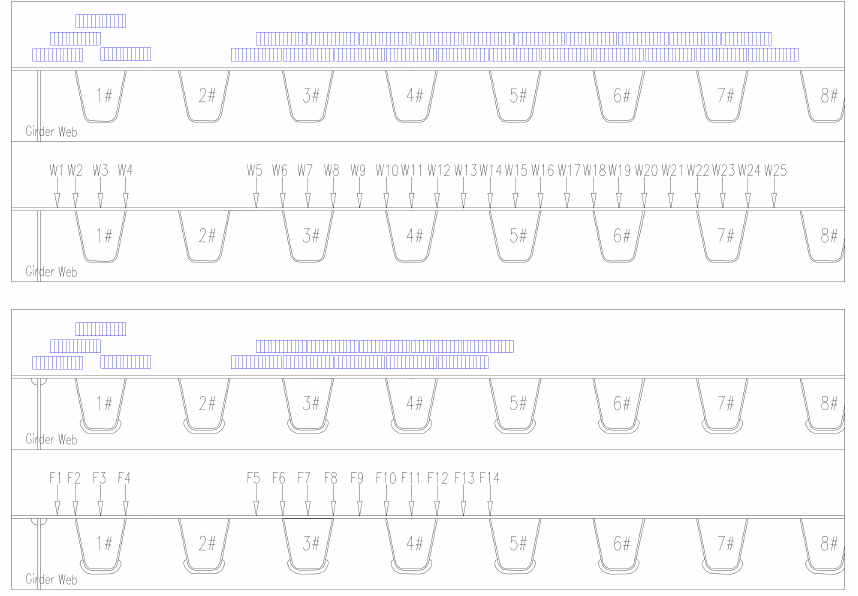
Figure 9. Loading